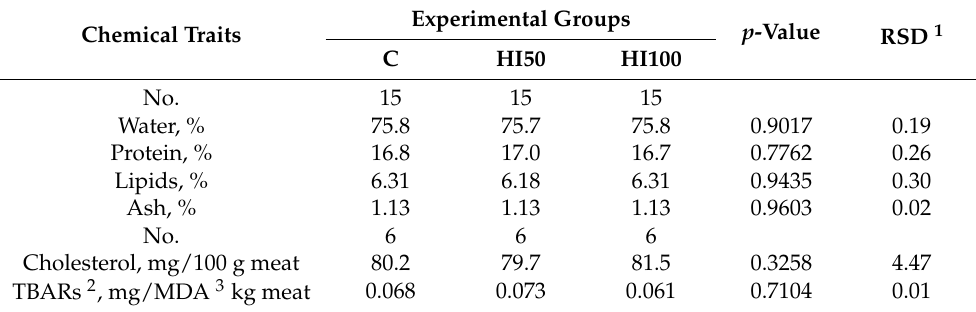
Table 4. Chemical quality of the leg meat of chickens fed with 0% (C), 50% (HI50) and 100% (HI100) substitution of soybean oil with Hermetia illucens (HI) larvae fat in their finisher diets. Chemical